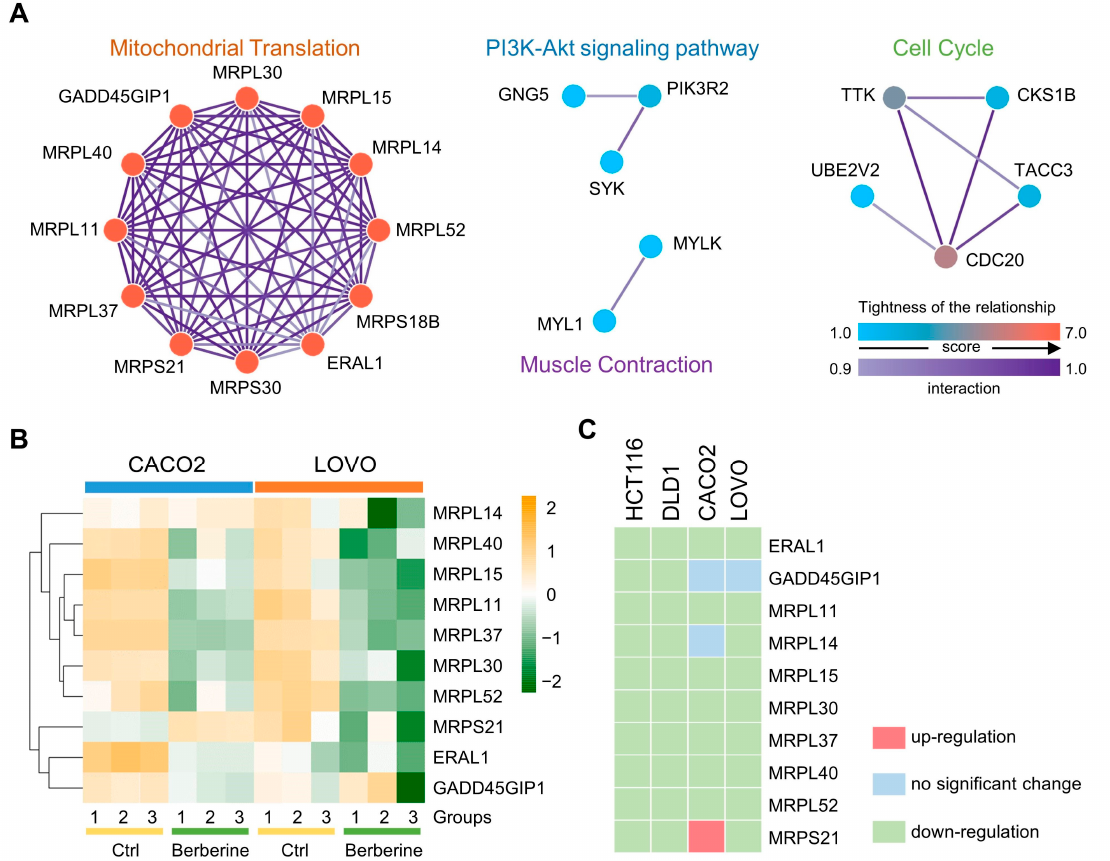
Figure 5. Selection of hub proteins in berberine-treated colon cancer cells. ( A ) Four clusters of Protein–Protein Interaction (PPI) networks from common DEPs between HCT116 and DLD1 cells. The color varying from blue to red represents the tightness of the relationship among DEPs; the deeper purple means a higher interaction score. ( B ) Heatmap of protein changes in berberine-treated CACO2 and LOVO cells. The data were obtained from re-analysis of previous reports [32]. Groups indicate three independent replicates used for LC-MS/MS analysis; color bar indicates the Z-score of intensities. ( C ) Ten proteins were commonly determined in four berberine-treated colon cancer cell lines, and trends of protein changes were indicated with three different colors.